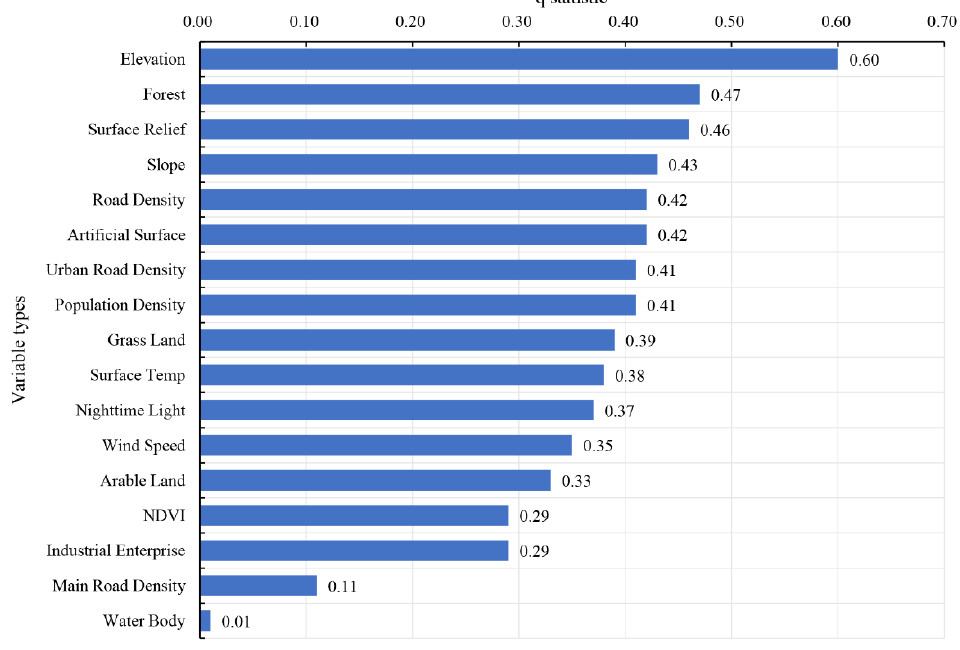
Figure 6. Results of factor detector.